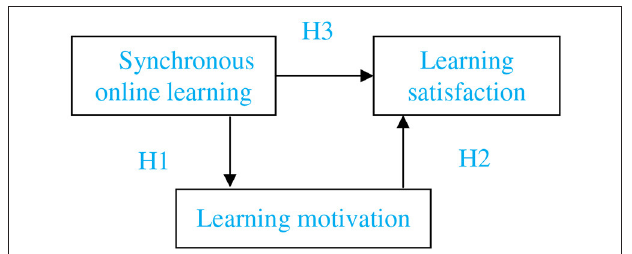
FIGURE 1 | Conceptual